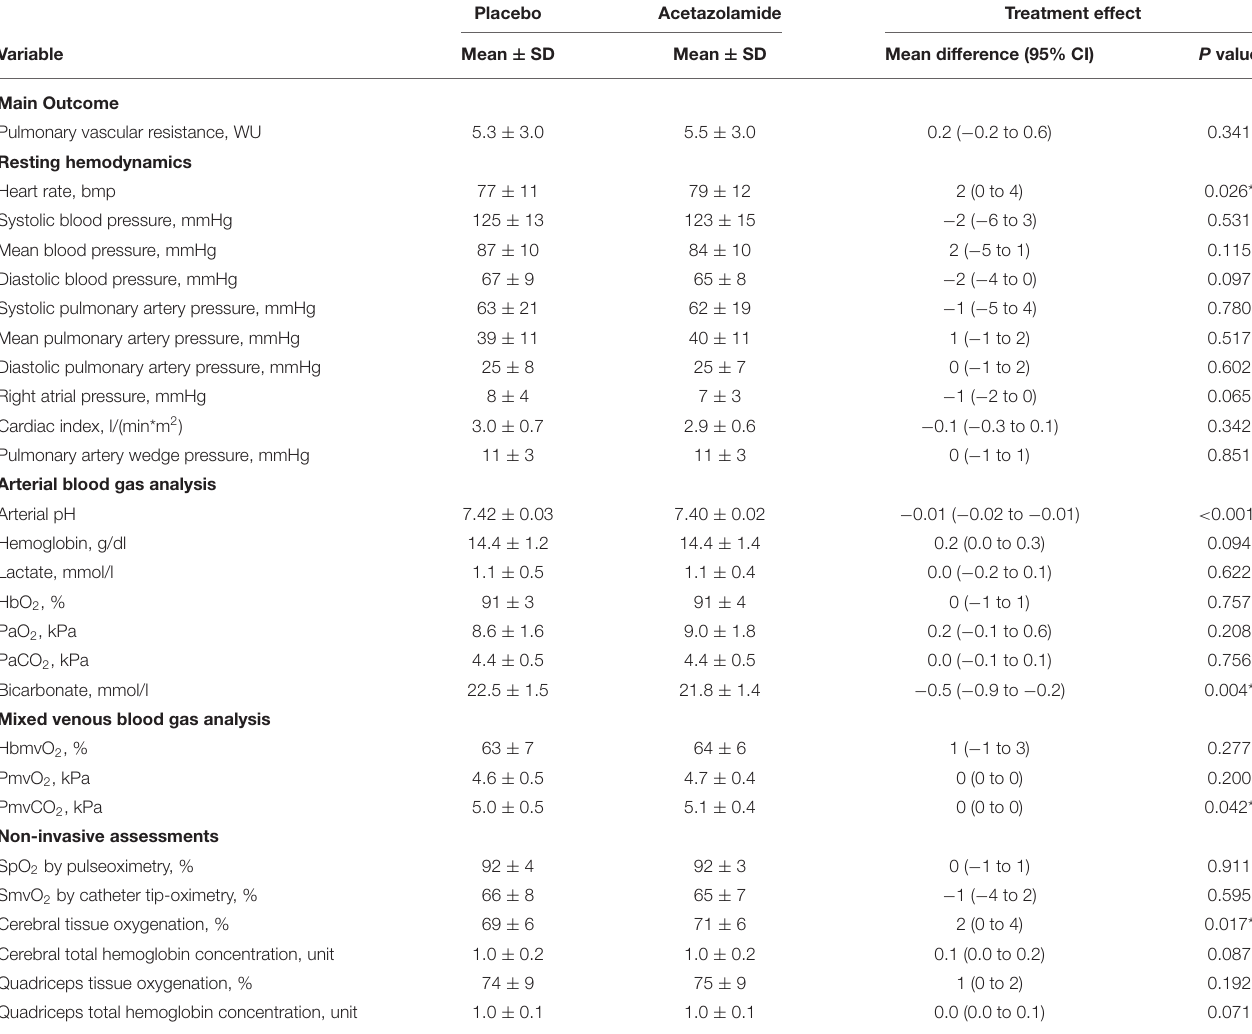
TABLE 2 | The effect of acetazolamide vs. placebo on invasive pulmonary hemodynamics, blood gases and tissue oxygenation after 60min under ambient